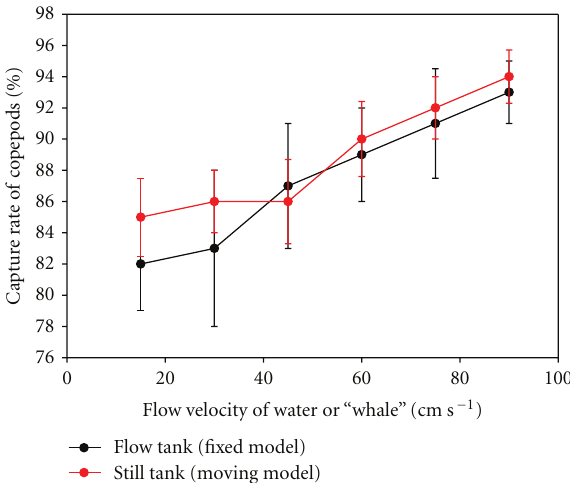
Figure 4: Capture rate of copepods ( Acartia ) by 1/15-scale physical model of Balaena whale head, including scaled baleen filtering apparatus, in flow and still water tanks (mean, N = 30; error bars = 1SD; water at 20 degrees C), measured by percentage of copepods observed entering “oral cavity” (on videorecordings) that did not emerge from rear of oral cavity after 10s.